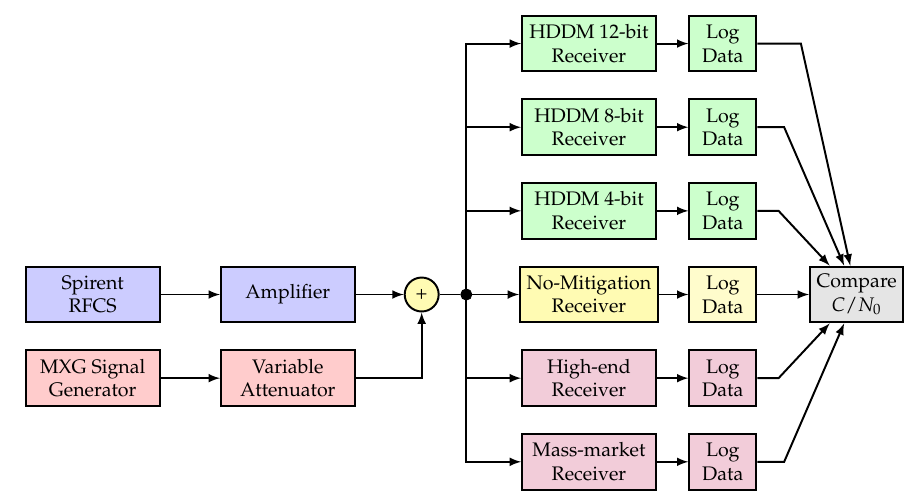
Figure 10. Experimental setup. ©IEEE. Adapted, with permission, from